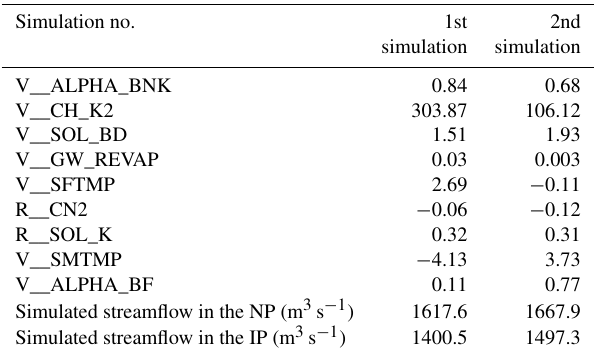
Table 8. Values of nine sensitivity parameters with similar simula- tion results and their simulated streamflow in the natural and im- pacted